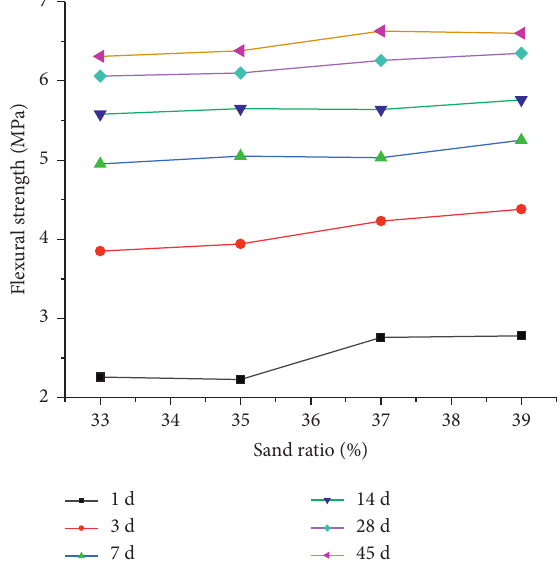
Figure 7: Influence of sand ratio on concrete flexural strength.